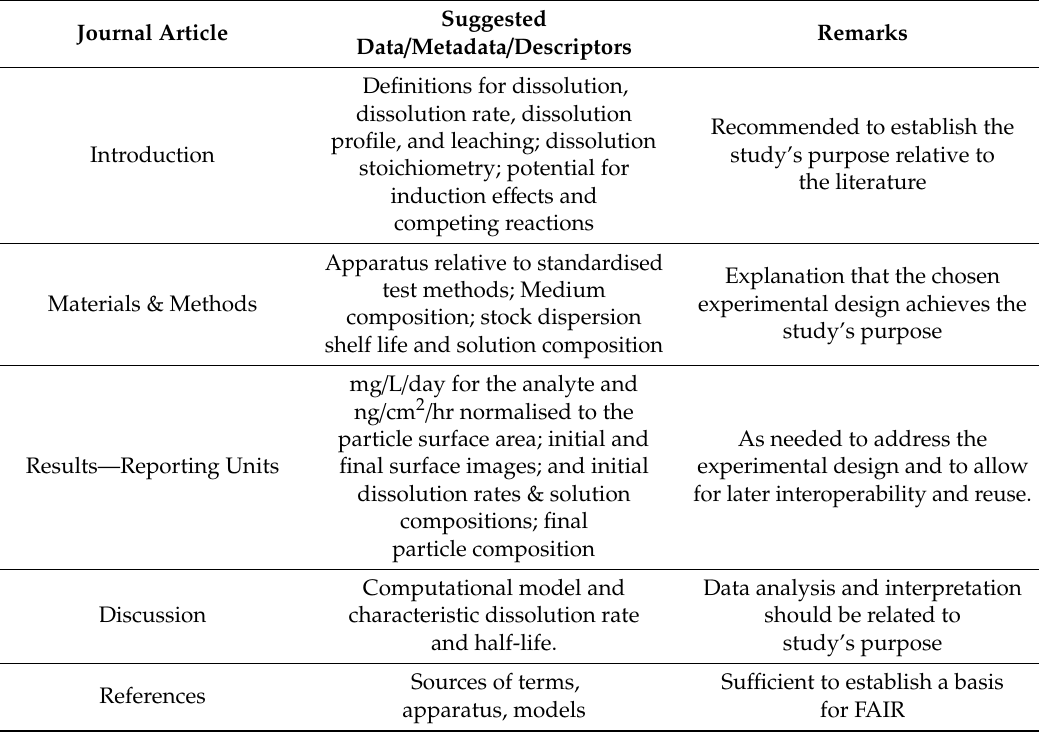
Table 3. Suggested Metadata in the Dissolution